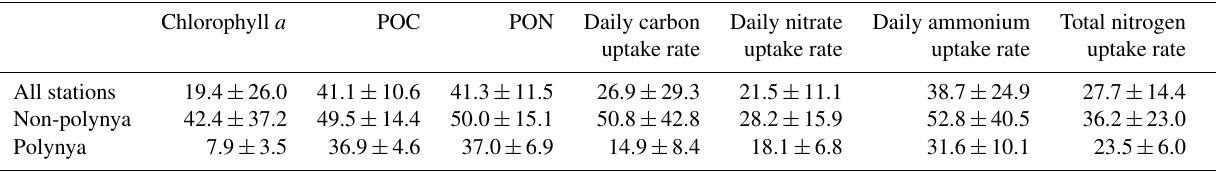
Table 1. Percentage contributions (%) of small phytoplankton to depth-integrated total concentrations of chlorophyll a , POC, PON and carbon and nitrogen uptake rates in the Amundsen Sea. Chlorophyll a POC PON Daily carbon Daily nitrate Daily ammonium Total nitrogen uptake rate uptake rate uptake rate uptake rate All stations